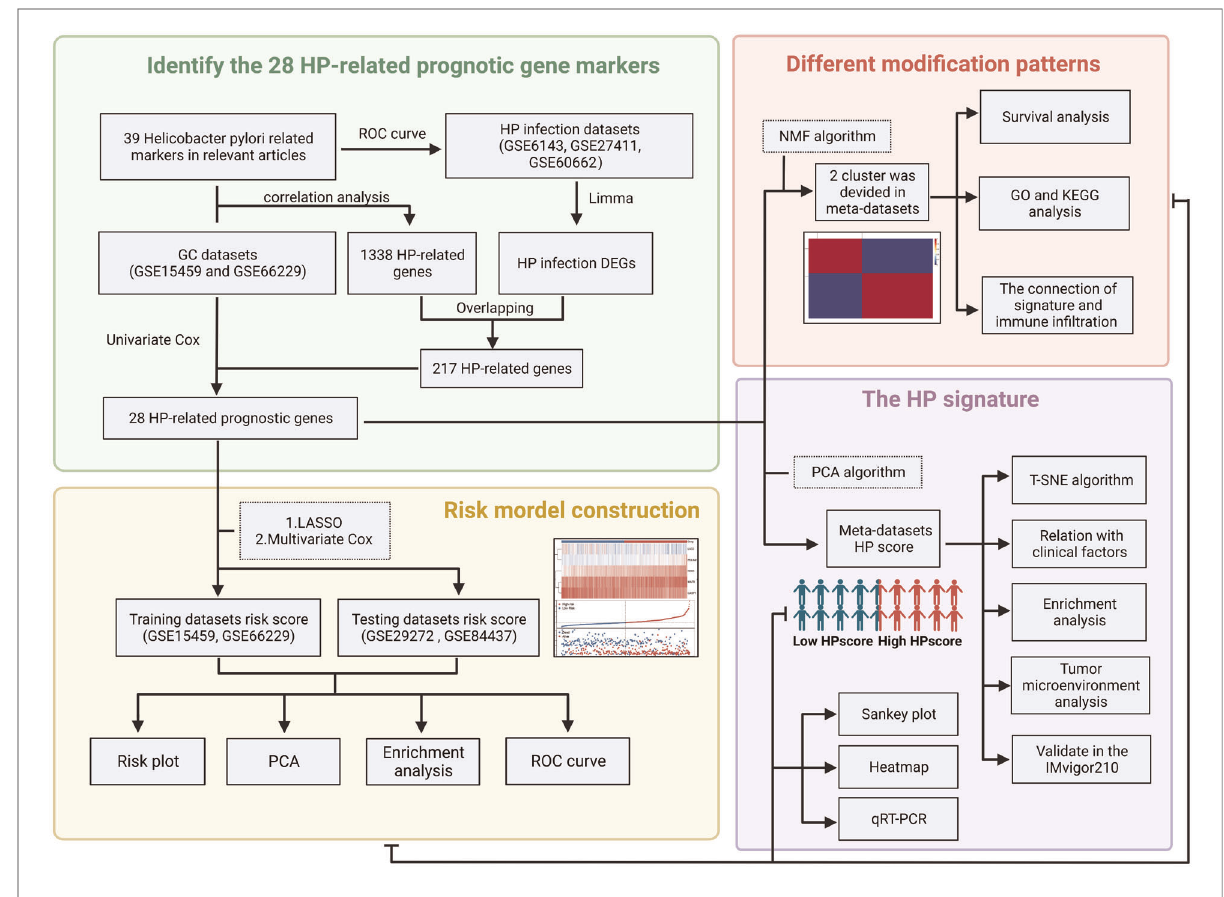
FIGURE 1 The fl ow chart of the present study (created with